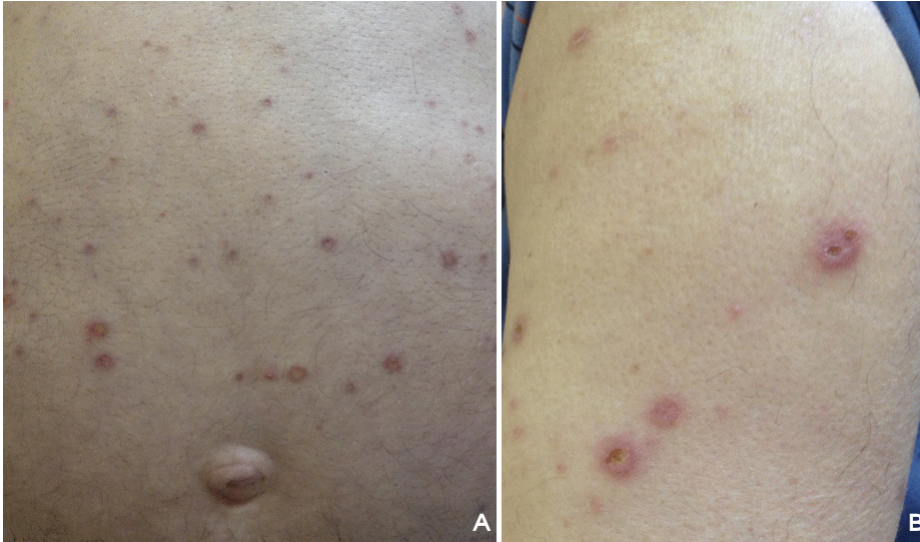
Figure 1: Active and resolving lesions of reactive perforating collagenosis after the third injection of ranibizumab. A) On the trunk, B) on the upper arm. Residual postinflammatory hyperpigmented macules are also seen at the site of prior lesions.